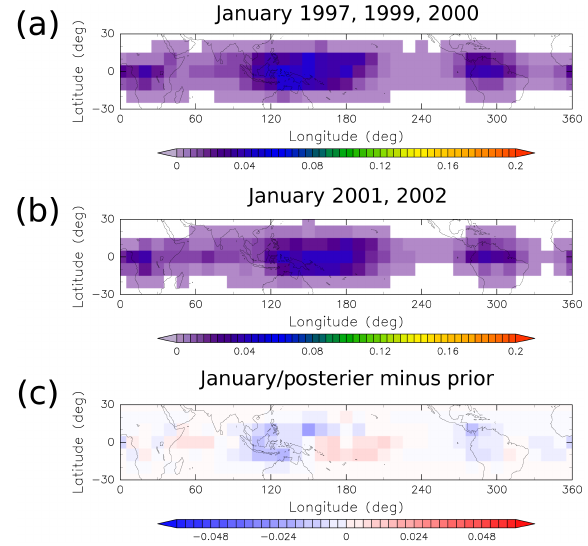
Figure 12. The same as Fig. 7 but for January. Those values in 1997, 1999, and 2000 are used for the calculations prior to the drop, while 2001 and 2002 are used for the posterior. Those in January 1998 are not used due to the influence of El Niño (see